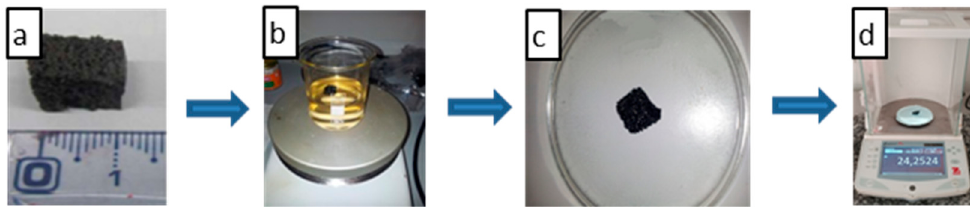
Figure 2. Sorption test procedure: The investigated foam ( a ) was dipped in the selected oil ( b ) at room temperature, under slow stirring, then the foam was left to rest on watch glass ( c ) for 30 s in order to remove the residual liquid and weighed ( d ).